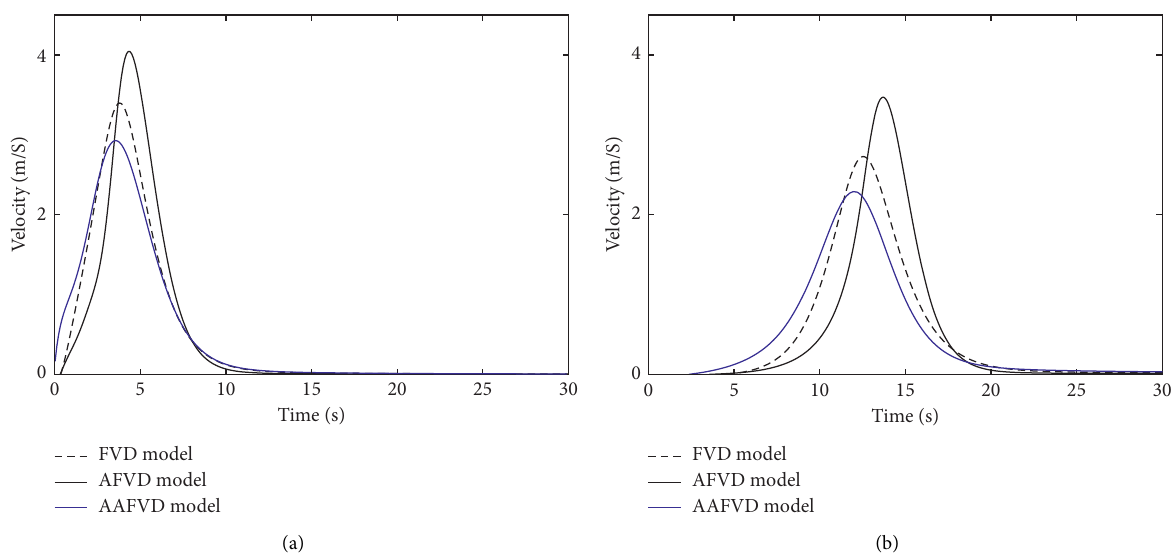
Figure 6: Acceleration of four HD vehicles during the departure process simulated by the FVD, AFVD, and AAFVD models: (a) 3 rd vehicle and (b) 9 th